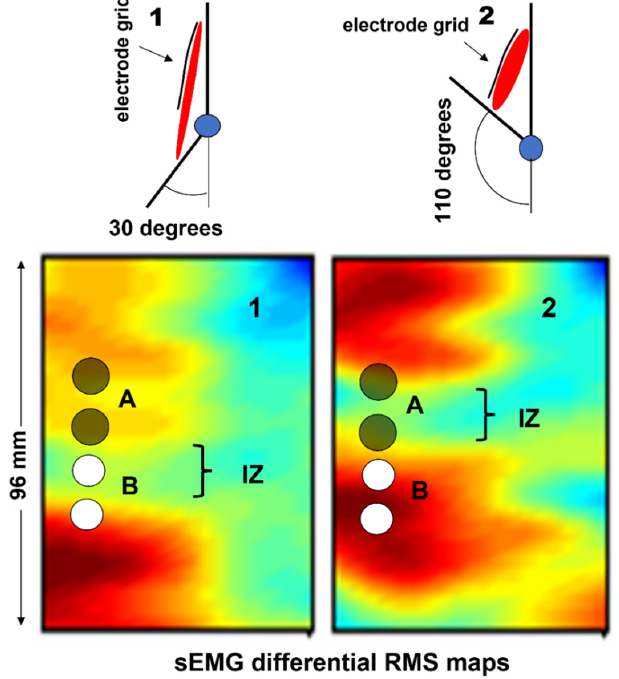
Figure 21. Example of a biceps brachii muscle shortening under the skin during a dynamic contraction. When the forearm flexes from 150 ◦ to 70 ◦ (internal angle with respect to the arm), the biceps muscle shortens under the array and the map changes from Map 1 to Map 2. Considering the white and the black pair of electrodes as being positioned by operators A and B, the white pair would indicate that elbow flexion causes an increase in the sEMG amplitude whereas the black pair would indicate the opposite. Great caution must be used during the placement of single electrode pairs for the study of dynamic contractions because the muscle geometry changes taking place under the electrodes cause sEMG variations that may be erroneously attributed to changes in the neural muscle drive when electrodes are placed on or near to the innervation zones (IZs). Adapted with permission from Figure 6.5 of Ref. [22]. Copyright Springer Verlag Italia, 2012.